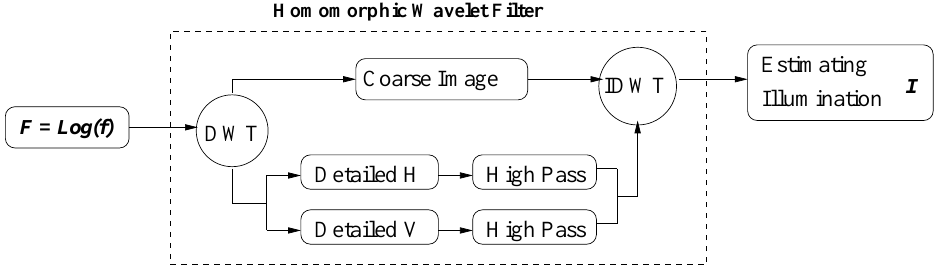
Figure 1. The flow chart of our homomorphic wavelet filter. DWT: dyadic wavelet transform analysis; IDWT: inverse dyadic wavelet transform; Detailed H: W 1 High Pass: Butterworth filter H ; Log means